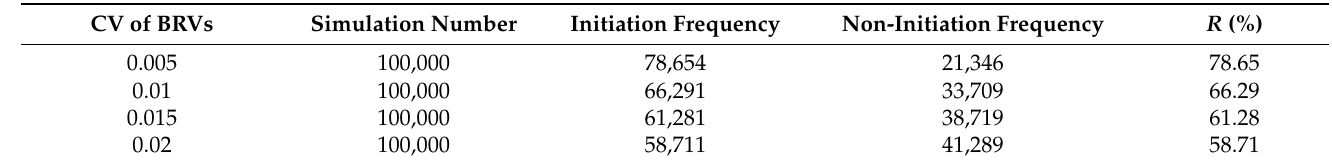
Table 6. The calculation results of the GABP-MCS in the IP study under the shock load condition where v is 1050 m/s.